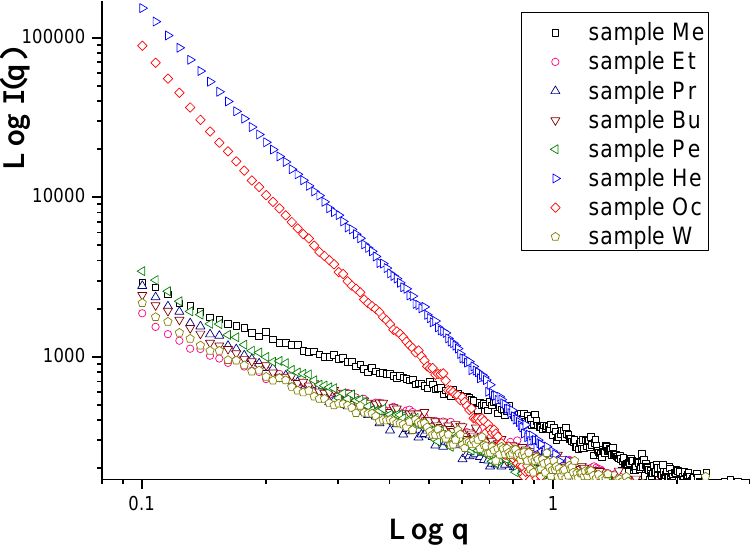
Figure 4. Double-logarithmic small-angle X-ray scattering (SAXS) curves of cellulose membranes.